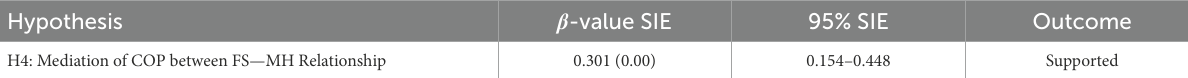
TABLE 7 Hypothesis testing for mediation.